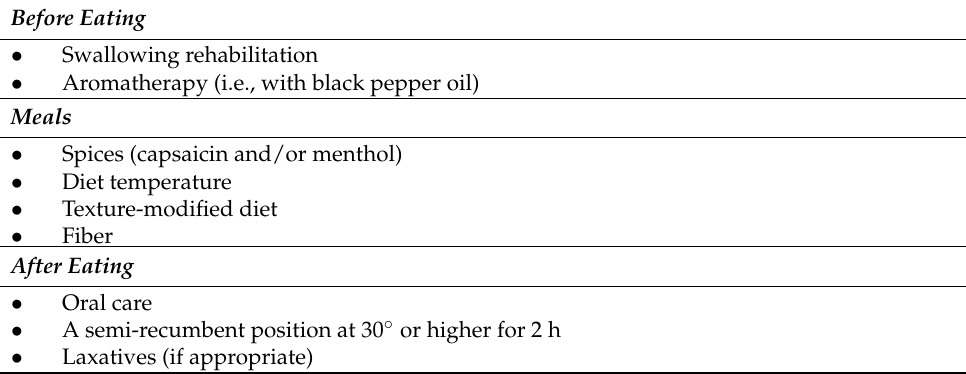
Table 1. How to prevent aspiration at